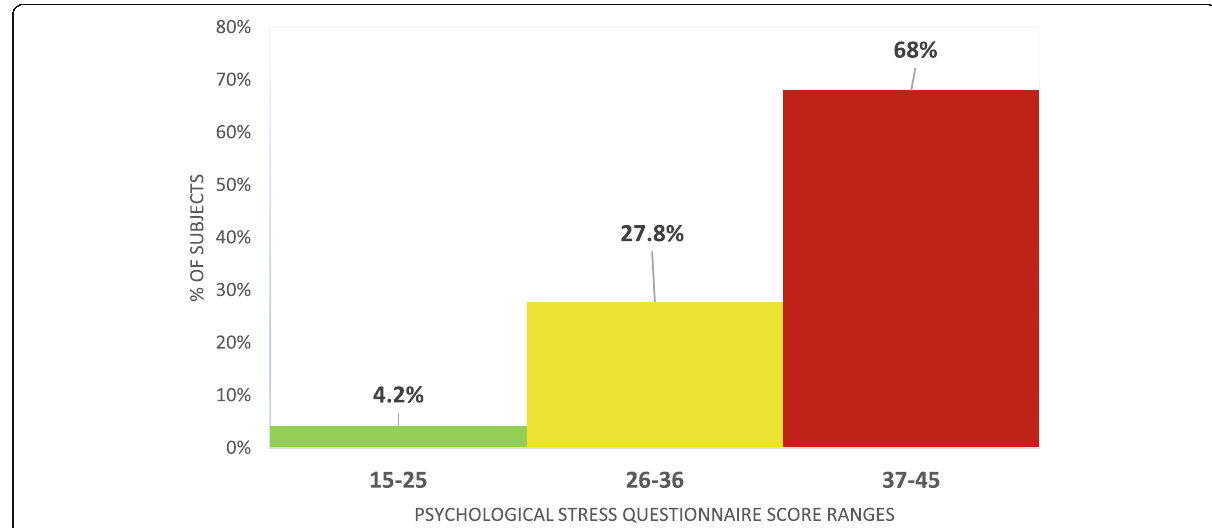
Fig. 1 Distribution of studied subjects as regard psychological stress questionnaire score